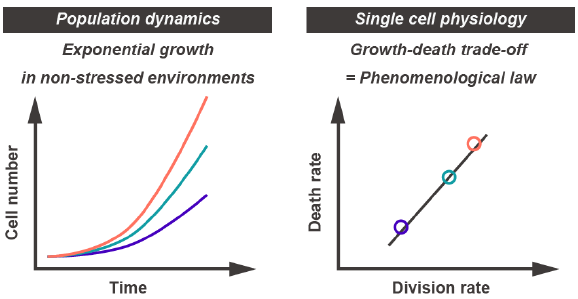
FIGURE 2: The growth-death trade-off in favorable